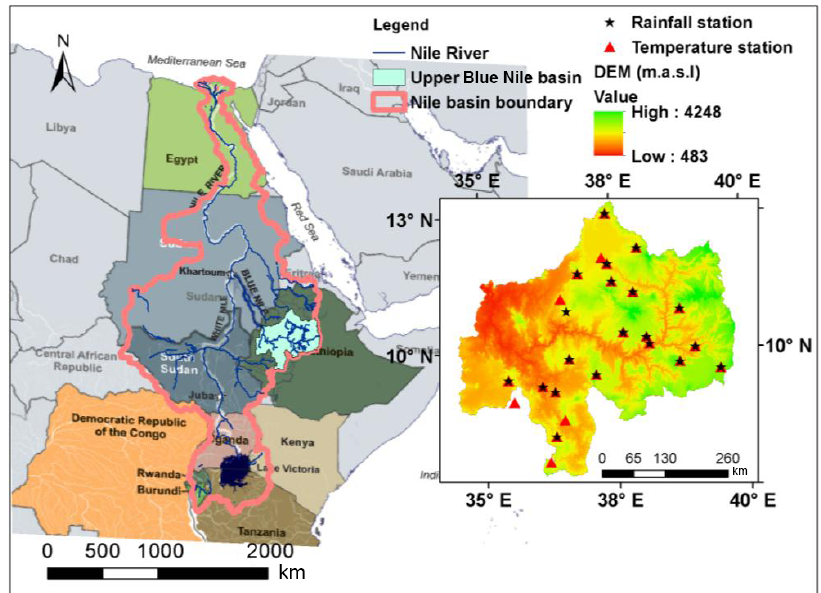
Figure 1. Location map of the study